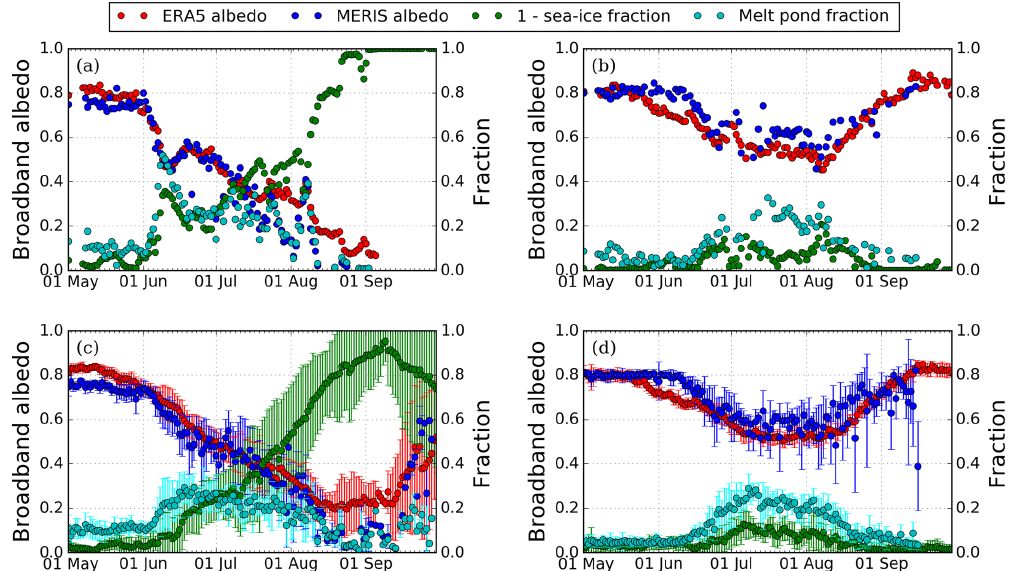
Figure 5. Grid cell broadband albedo from ERA5 (red) and MERIS (blue), the complement of ERA5 sea-ice fraction (green), and the MERIS melt pond fraction (cyan) over a first-year ice area in the Beaufort Sea near Utqia˙gvik (75 ◦ N, 155 ◦ W) (a, c) and a multiyear ice area north of Greenland (84.5 ◦ N, 35 ◦ W) (b, d) . Panels (a) and (b) show the values between May and September 2007. Panels (c) and (d) show the values that were averaged over the years from 2003 to 2011 (points) and their standard deviations (error